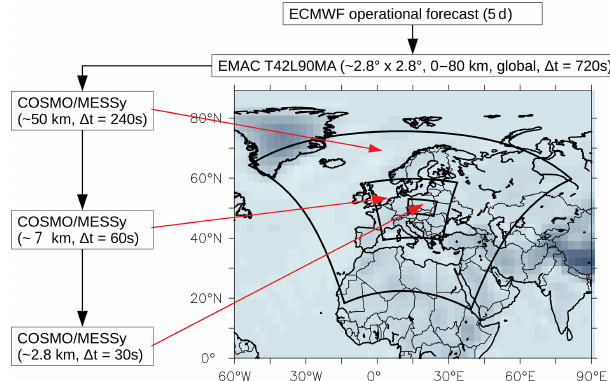
Figure 1. Overview of all three COSMO/MESSy domains over Eu- rope (CM50), over central Europe (CM7) and over the USCB in Poland (CM2.8), as well as the corresponding temporal and spatial resolution. The black arrows indicate the data exchange between the different models. The driving model EMAC is nudged towards di- vergency, vorticity, temperature and the logarithm of surface pres- sure from the ECMWF. SST and SIC are prescribed as boundary conditions.